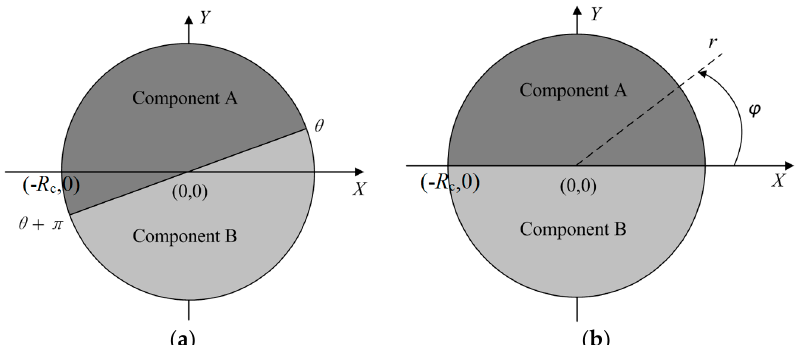
Figure 3. The turntable in a two dimensional cylindrical coordinate system (dark gray represents Component A, light gray represents Component B). ( a ) The initial position of the turntable; ( b ) The position of the turntable during rotation.